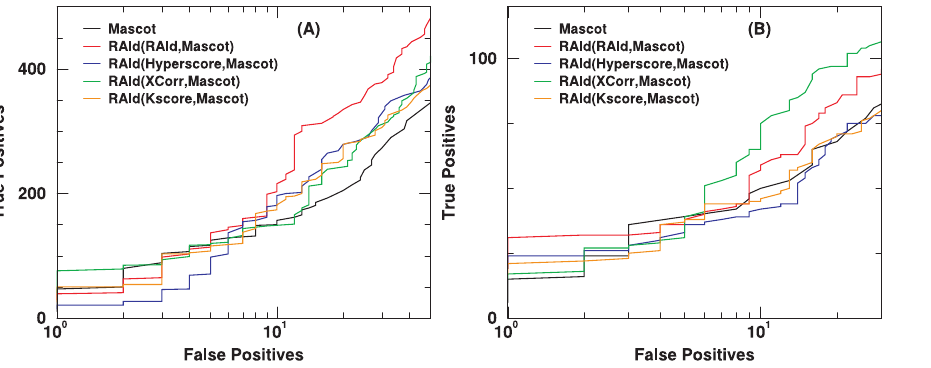
Figure 10. Example of reanalyzing output files from other search engine by combining with statistical significance assignment from RAId_aPS. In this example, we use the Mascot output files resulting from querying profile spectra (panel (A), the NHLBI data set) and centroid spectra (panel (B), A1–A4 of the ISB data set [28]) to the NCBI’s nr database with proteins highly homologous to those that were present in the mixture removed. Since each data set is from a known mixture of proteins, it is possible to remove the proteins homologous to the true positives from the nr database. We then combine the calibrated E -value [4] of Mascot with the E -value obtained from RAId_aPS when either RAId score, Hyperscore, K-score or XCorr is